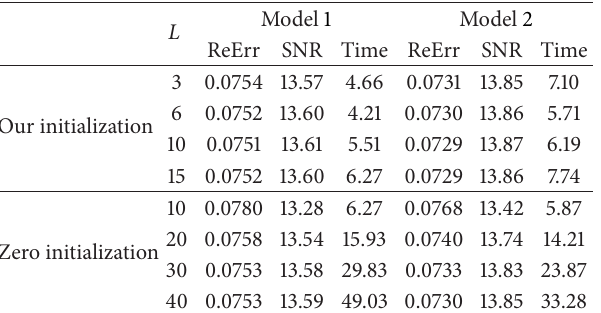
Table 2: Summarized results of the proposed models for different values of 𝐿 with our initialization and zero